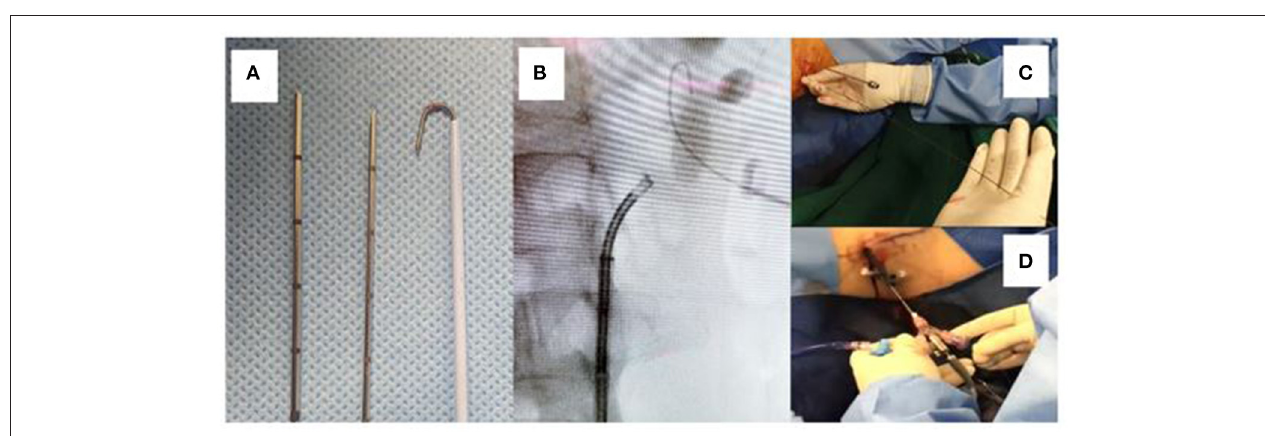
Frontiers in Surgery |